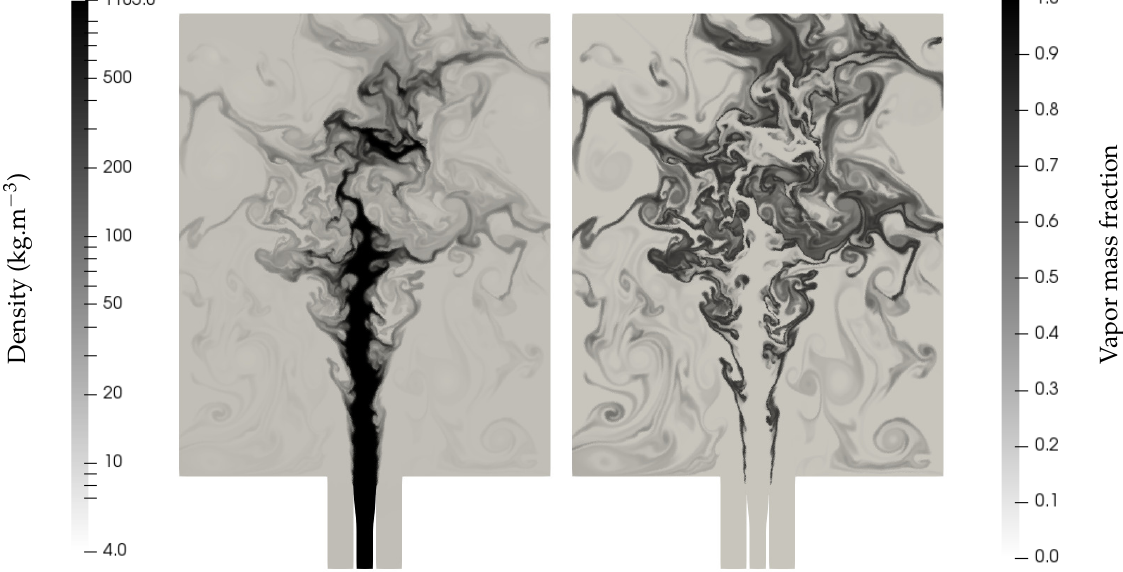
Figure 12. Density and vapor mass fraction profiles of a liquid oxygen jet surrounded by hydrogen at high speed entering a combustion chamber of a cryotechnic rocket engine. Shear effects induce jet fragmentation. The filaments separating the main liquid core and the gas gradually vanish as a consequence of evaporation. The computation was done with the MUSCL scheme with Superbee limiter [27] and CFL = 0.7. The solution is given at t 4.1 ms. The mesh is unstructured and made of ≈ about 360,000